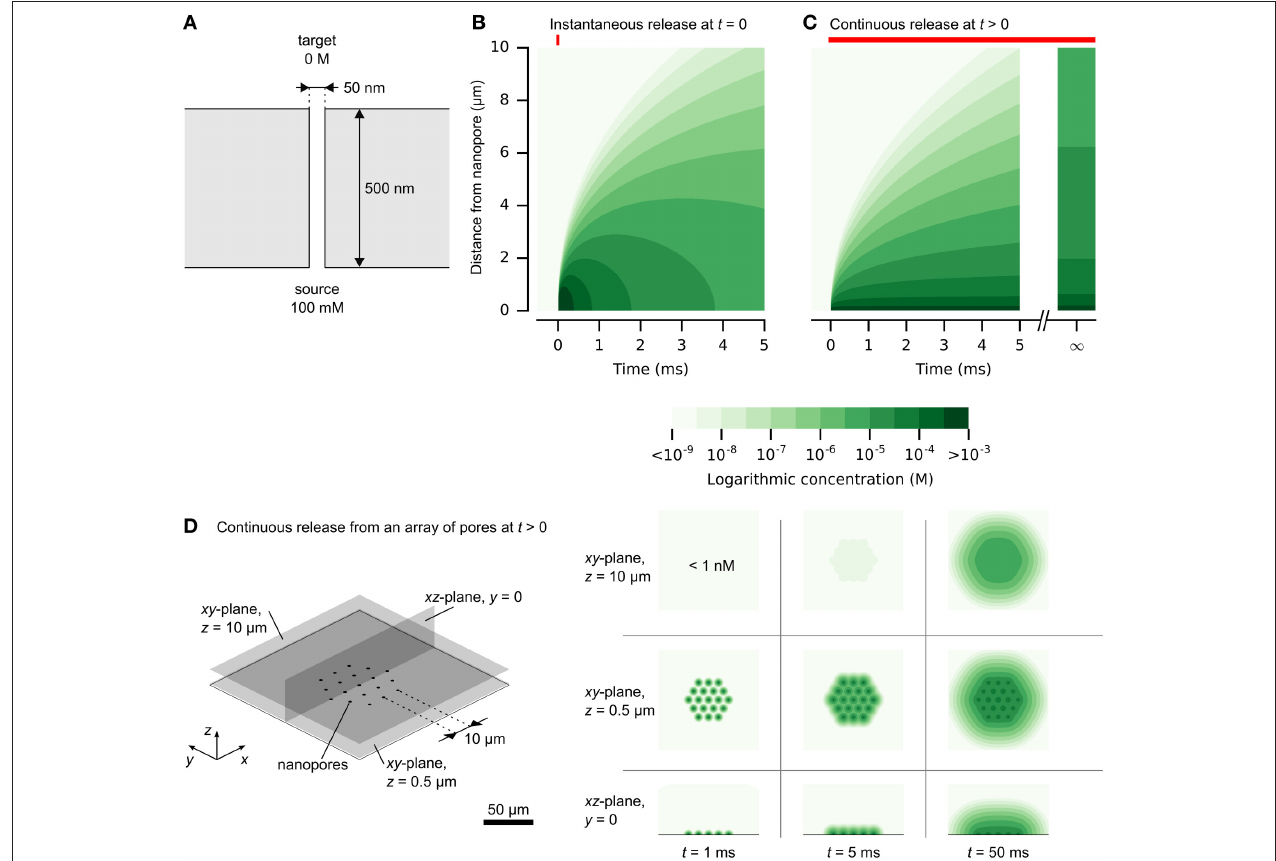
FIGURE 2 | Release and spread of chemical signals from nanopores by diffusion. (A) The physical setup of a single nanopore with diameter of 50 nm and length of 500nm. (B) Propagation of an instantaneous chemical impulse of 10 6 molecules at t = 0. Concentrations 1 µ m away from the nanopore source rise and fall by orders of magnitudes within milliseconds . (C) Propagation of constant release from a nanopore, illustrated in (A), turned on at t > 0. A high concentration is established quickly near the nanopore. At larger distances, the concentration approaches a steady state, which is diluted by orders of magnitude in comparison to the concentration within 1 µ m of the nanopore. (D) A dense array of nanopores can be resolved at close distances. Here, the release rate at each nanopore is the same as in (C) and the nanopores are separated by 10 µ m. Color scale is logarithmic and shown in discrete steps for clarity. A reproduction with a linear color scale is available as Figure 1S in the Supplementary